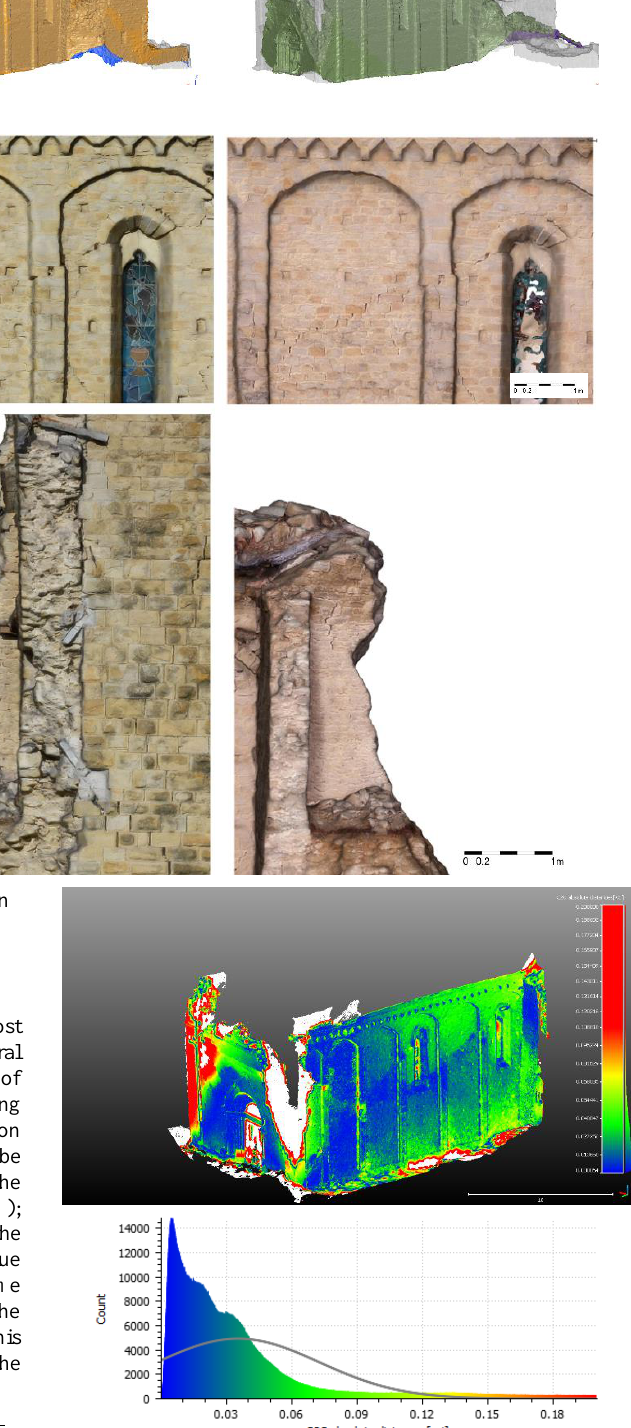
Figure 10. Comparison of t2 on t1 point clouds and associated histogram of values distribution included in 0<v<0.2m. In grey colours values associated to areas in T2>0.20m respect to